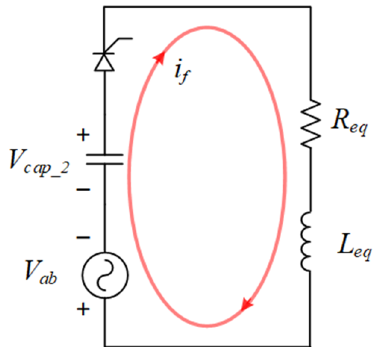
Figure 10. Circuit analysis when operating the proposed sub-modules in accordance with an FRT strategy.